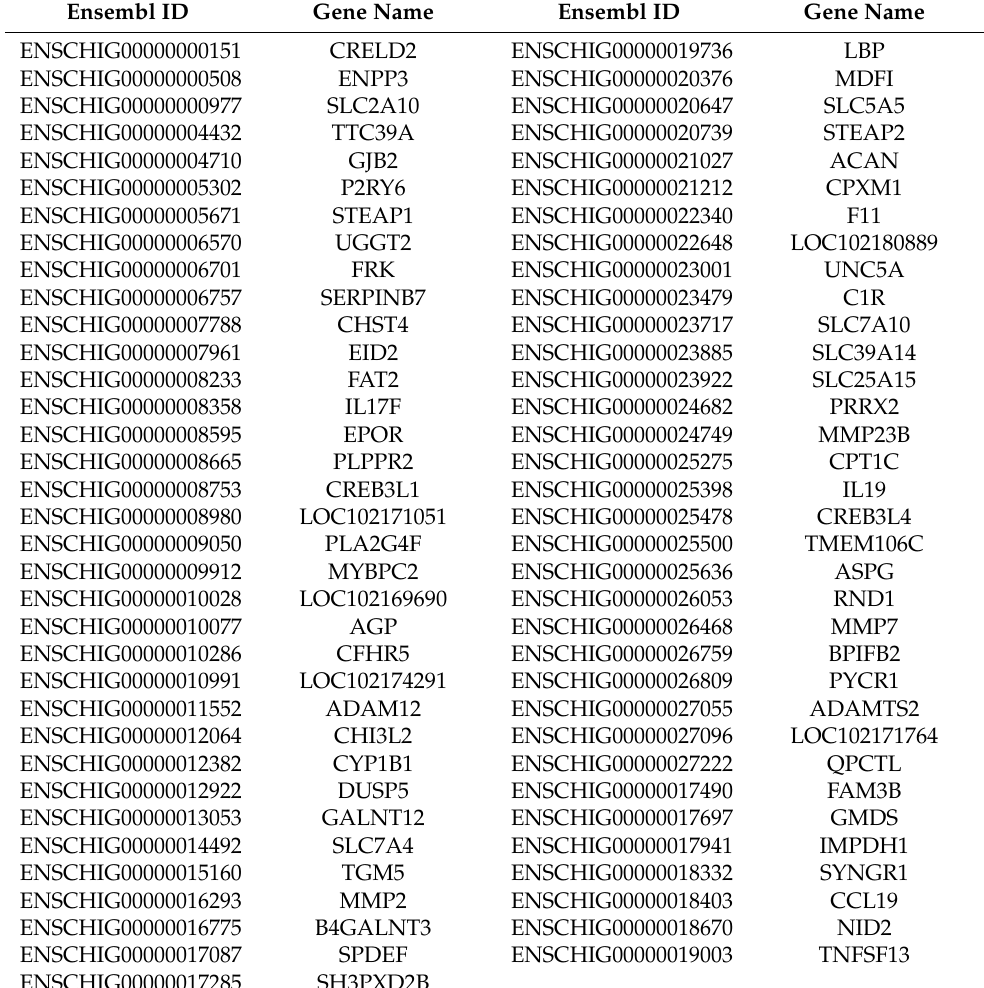
Table A5. The differentially expressed genes listed in profile 19.